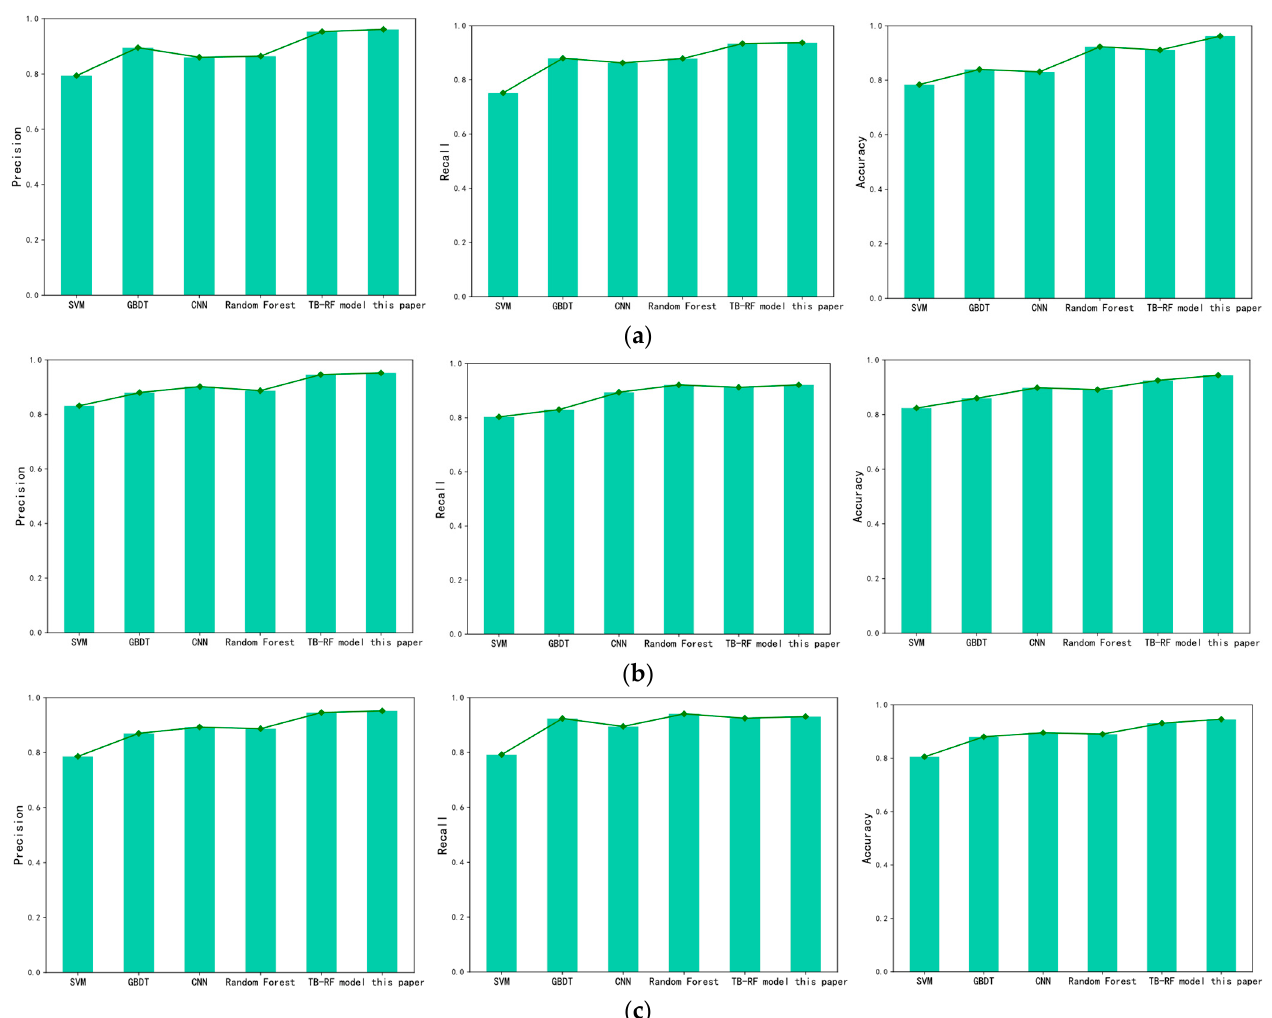
Figure 10. Comparative results of indicators from different models on the experimental dataset. ( a ) Comparison Results of Model Indicators on CIC‑ISD2017 Dataset. ( b ) Comparison Results of Model Indicators on KDDCUP99 Dataset. ( c ) Comparison results of model indicators on the NSLKDD dataset.